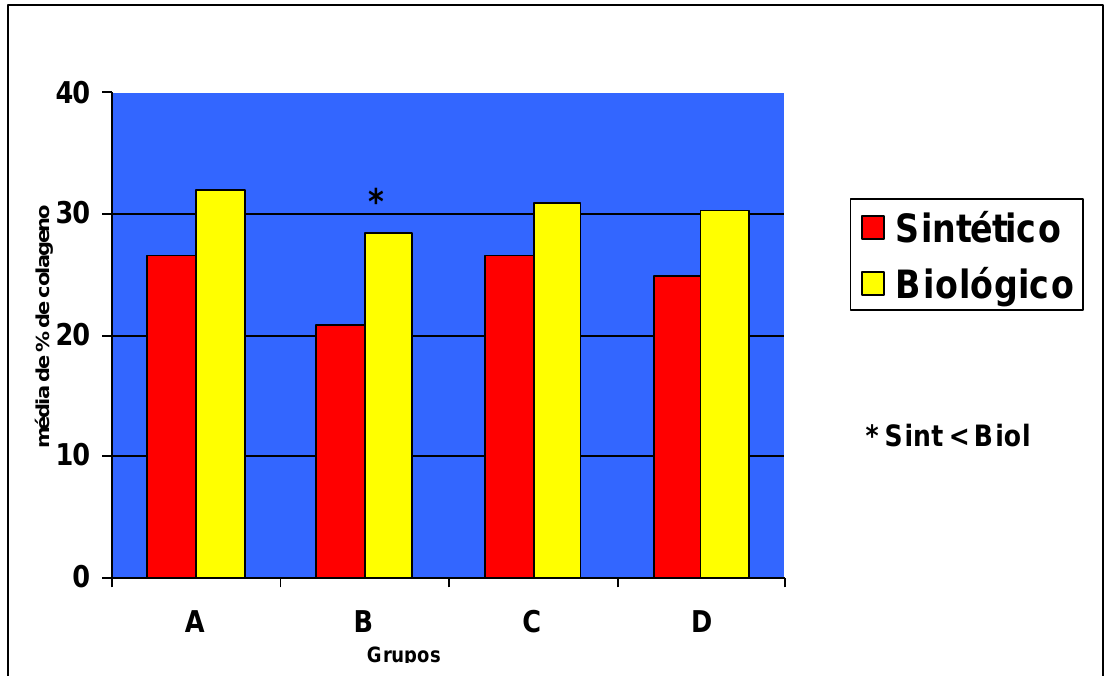
FIGURA 3 – Distribuição das médias da porcentagem de colágeno da anastomose jejuno- jejunal após síntese com adesivo sintético ou biológico entre dois(GA), quatro (GB), seis (GC) e oito (GD) pontos aos 14 dias de